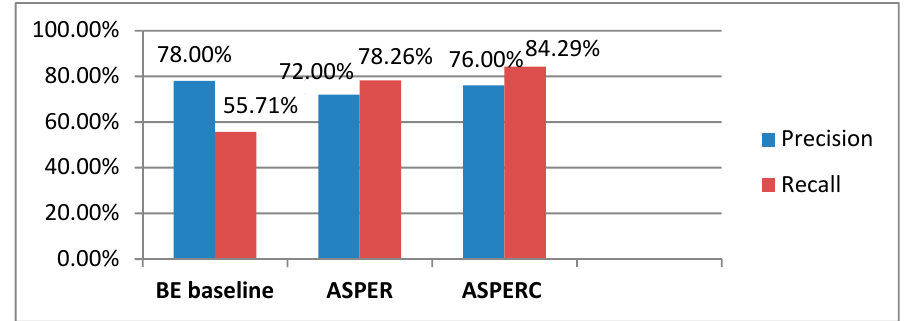
Figure 9. Precision and recall of ASPER model, ASPERC model, and BE baseline in the laptop dataset.